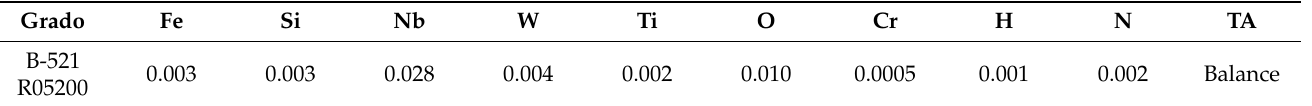
Table 2. Chemical composition of the B 521 tantalum alloy UNS Grade R05200.